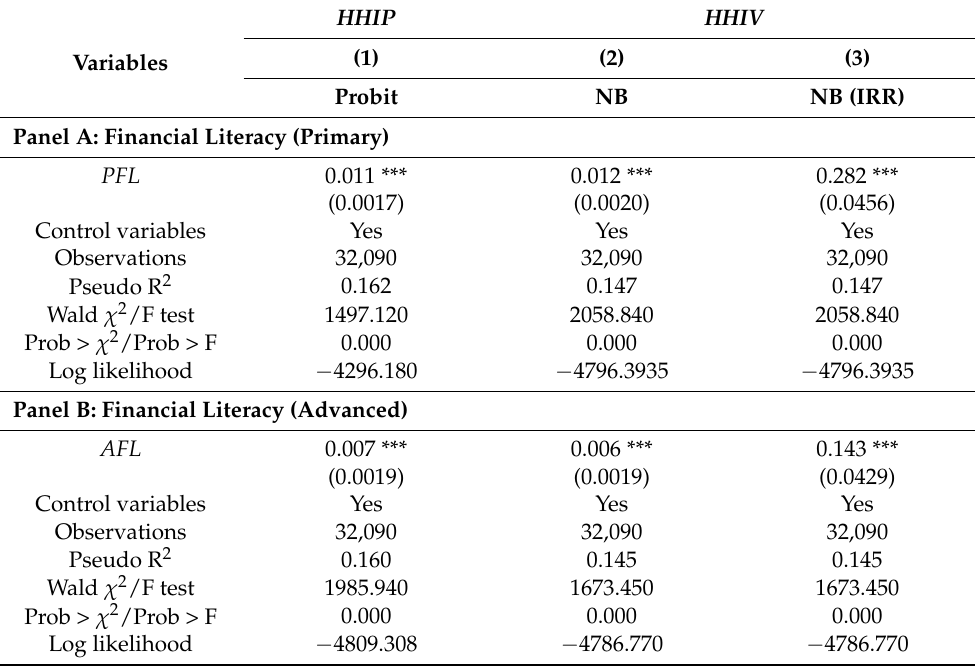
Table 6. Regression results considering the degree of financial